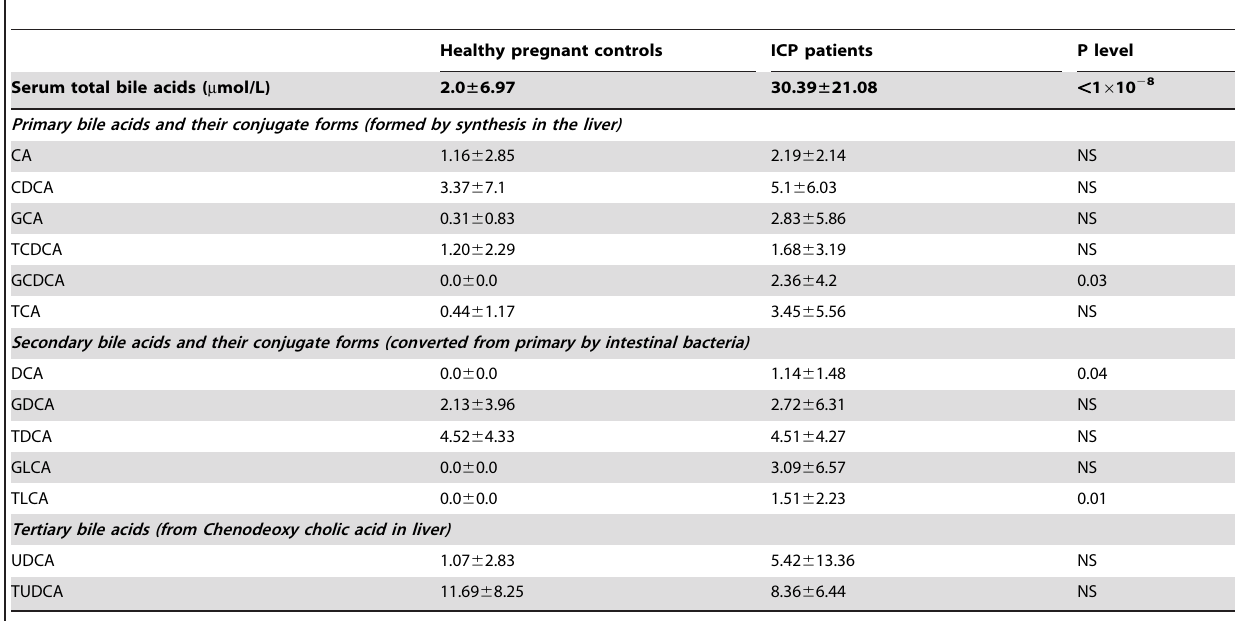
Table 2. Bile acid profile in healthy pregnant women and patients with intrahepatic cholestasis of pregnancy (ICP).